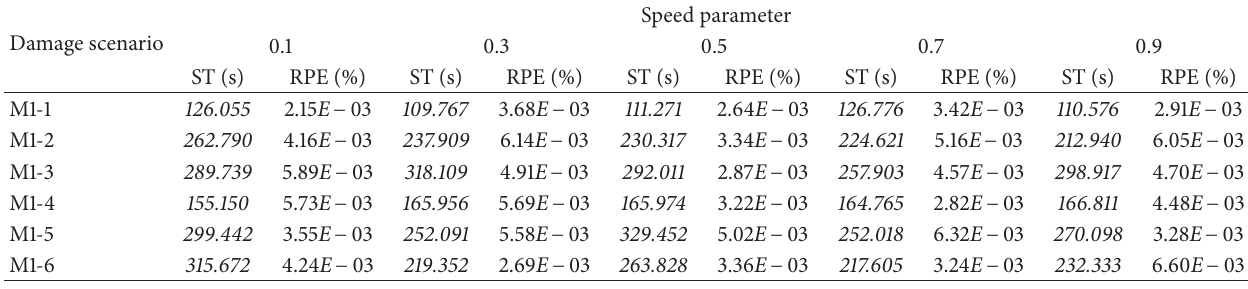
Table 9: Solution time, loops, and RPE of DDM method for model 2.